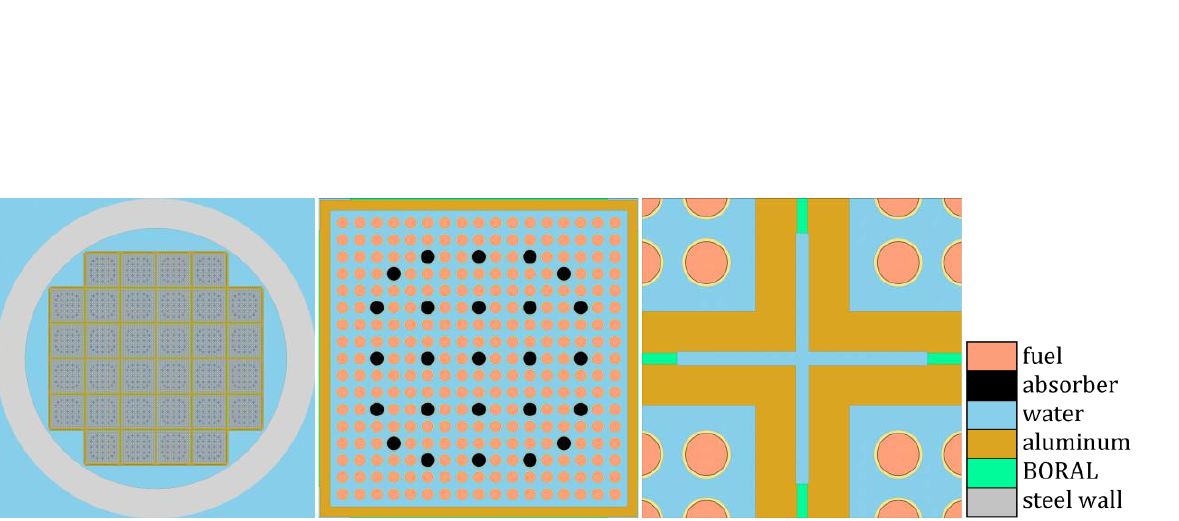
Figure 2. Spent fuel cask criticality model in Serpent 2.